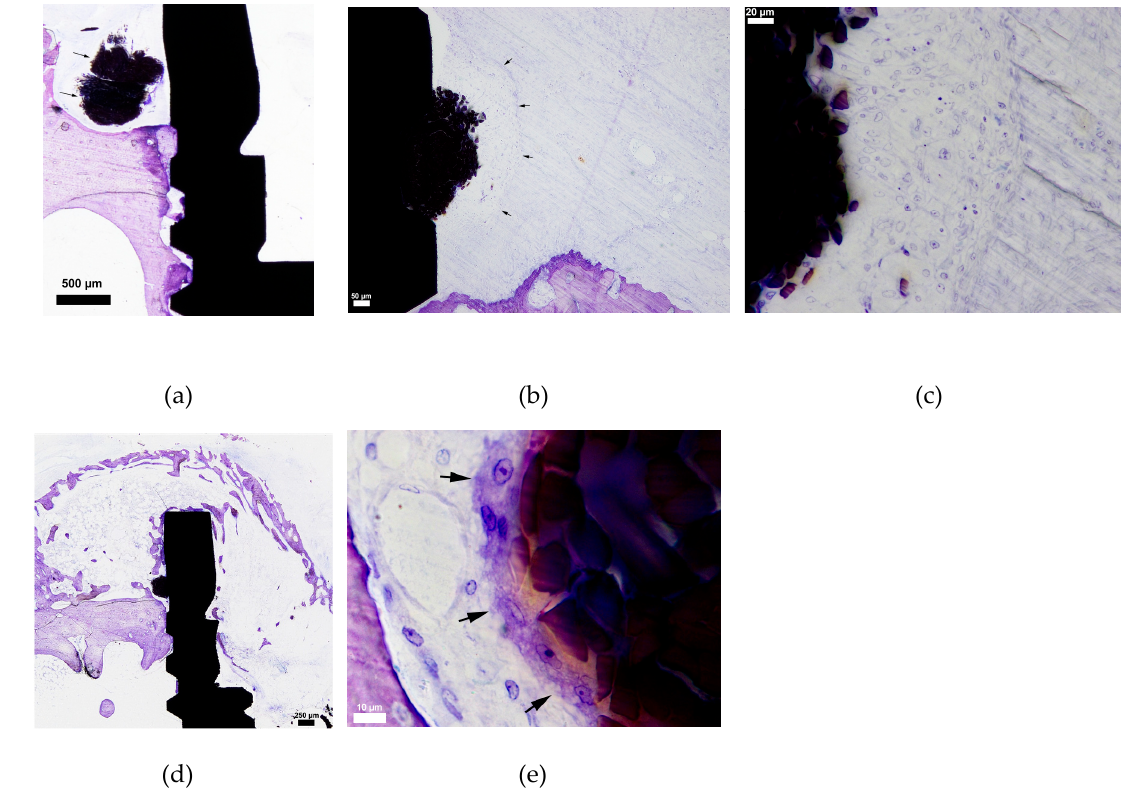
Figure 6. Sample figures from different silk sections. ( a ) Survey figure of a typical section with a silk ligature (arrows) above a partly resorbed cortical bone surface in the periosteal region. ( b ) In some cases, the silk ligatures (in close contact to the implant) were surrounded by a thick cellular infiltrate layer (arrows) dominated by macrophages of various sizes and shapes. Outside this formation, loose connective tissue was formed. ( c ) The same section in higher resolution. ( d ) This figure illustrates a rather large “dome-like” callus formation of the periosteal bone and it seems like the implant part above the silk ligature is almost covered by new formed bone. ( e ) The arrows illustrate a large, elongated multinucleated giant cell (MNGC) in intimate contact with the silk.